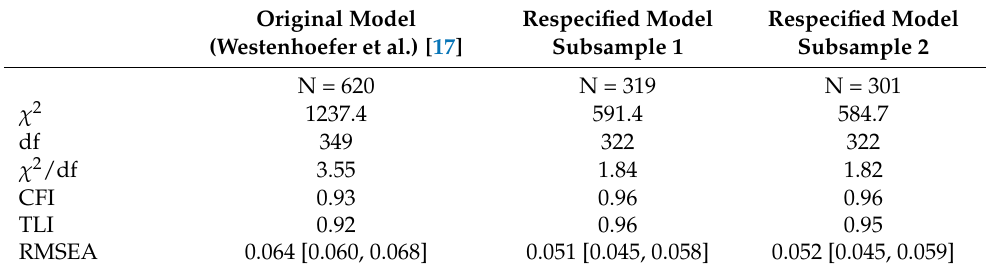
Table 1. Model fit statistics and reliability estimates obtained from confirmatory factor analyses of the flexible and rigid cognitive restraint scales in two random samples of the NutriNet-Sant é study (2017) and comparison with the respective estimates in the original publication.